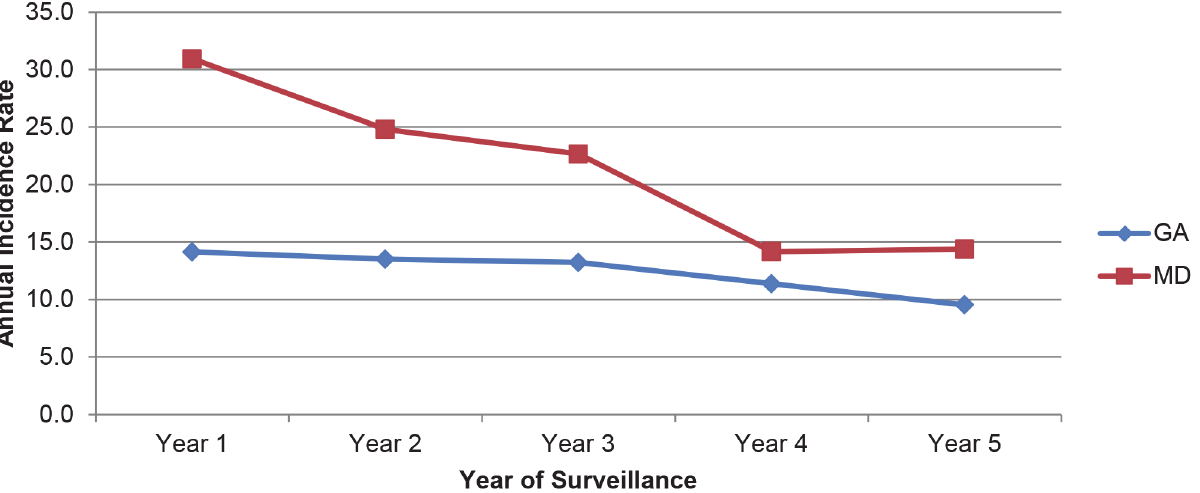
Fig 1. Annual candidemia incidence rates per 100,000 person-years, by year and location, 2008 –